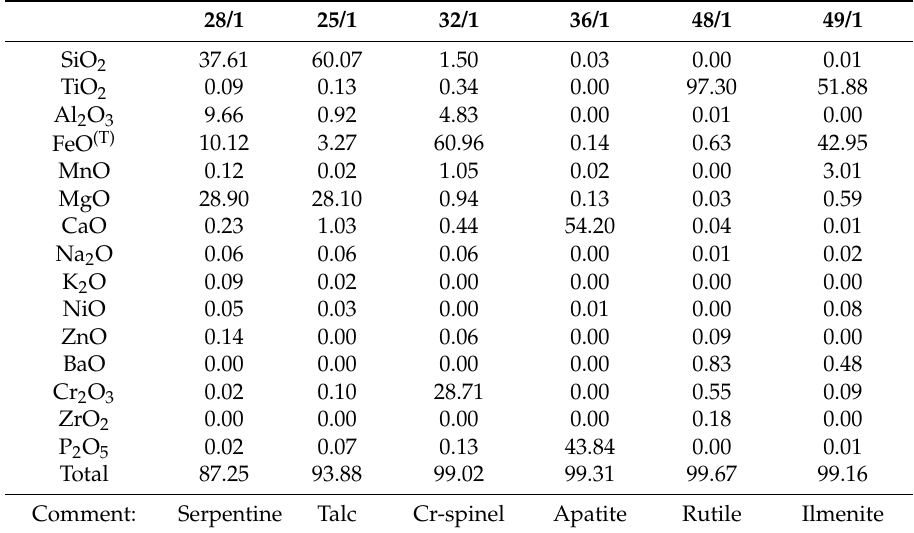
Table 3. Mineral composition of the altered silicates, and the accessory mineral phases present in the Holenarsipur